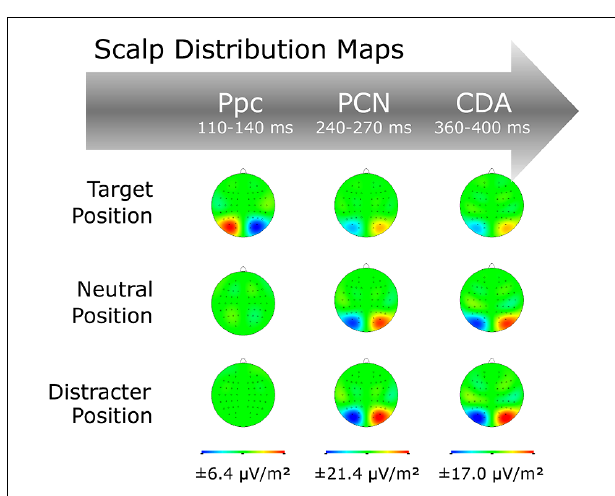
FIGURE 4 | Scalp distribution maps for the Ppc, PCN, and CDA waves as a function of target position sequence (TT,TN,TD).